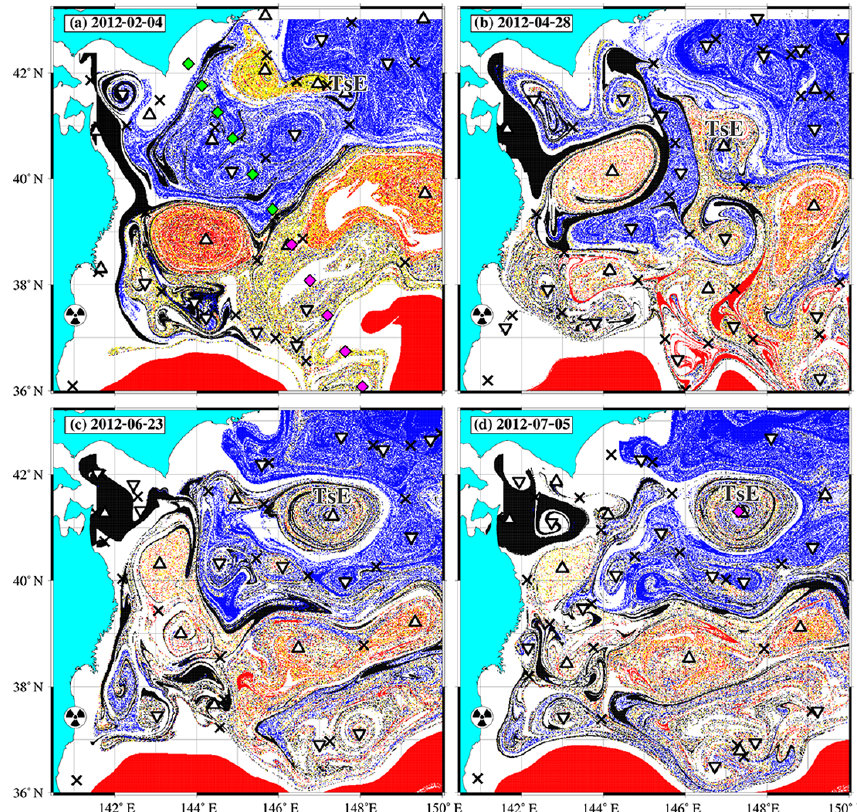
Figure 4. The Lagrangian maps in the study area in the first half of 2012. (a) The locations of stations in the beginning of February with surface seawater samples (collected by Kumamoto et al., 2014) with measured radiocesium concentrations at the background level (the green diamonds) and with higher concentration levels (the magenta diamonds). (b–d) The Lagrangian maps show evolution of the Tsugaru eddy (TsE), which originated on 4 February 2012 (a) after splitting of the HE and was sampled by Budyansky et al. (2015) at station 84 on 5 July 2012 and shown to have increased radiocesium concentrations (the magenta diamond in d